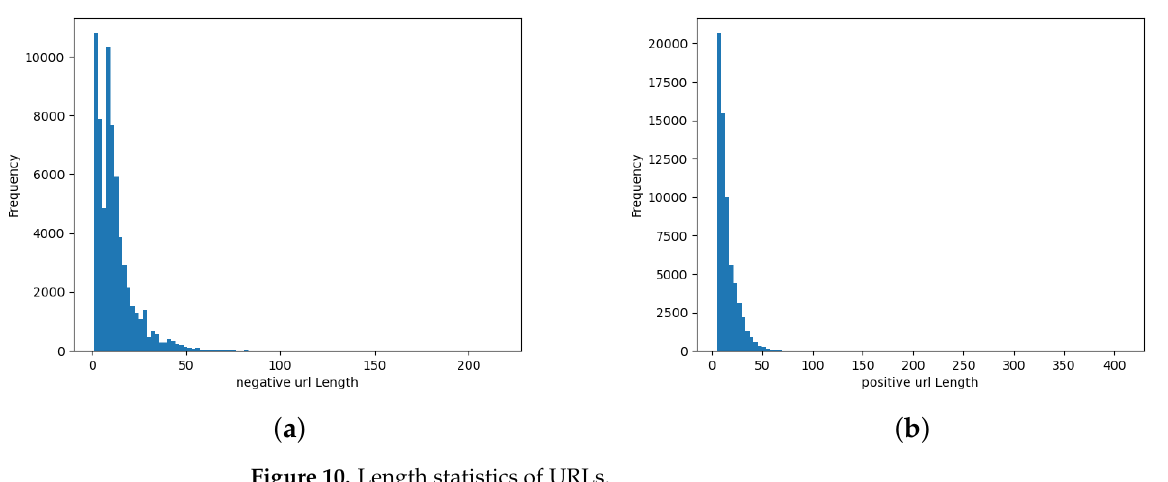
Figure 10. Length statistics of URLs.